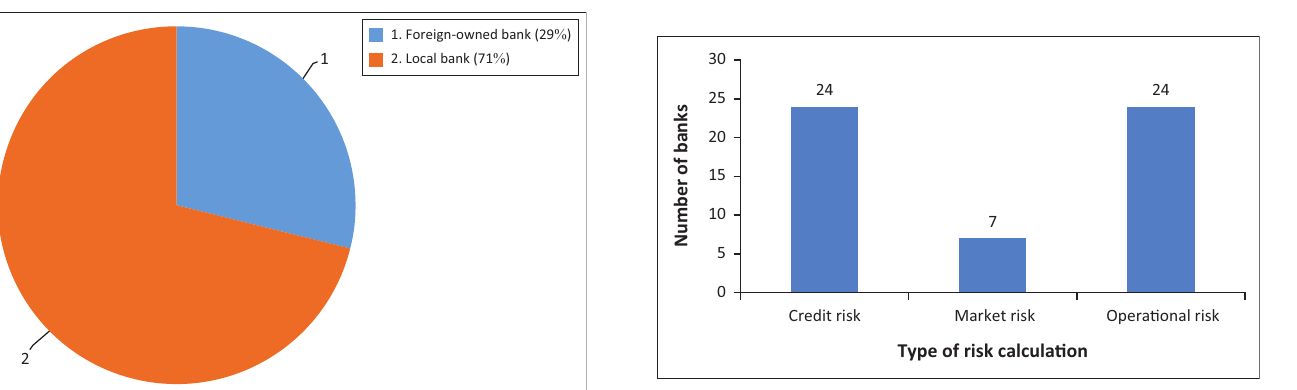
FIG URE 2: Level of Basel implementation.